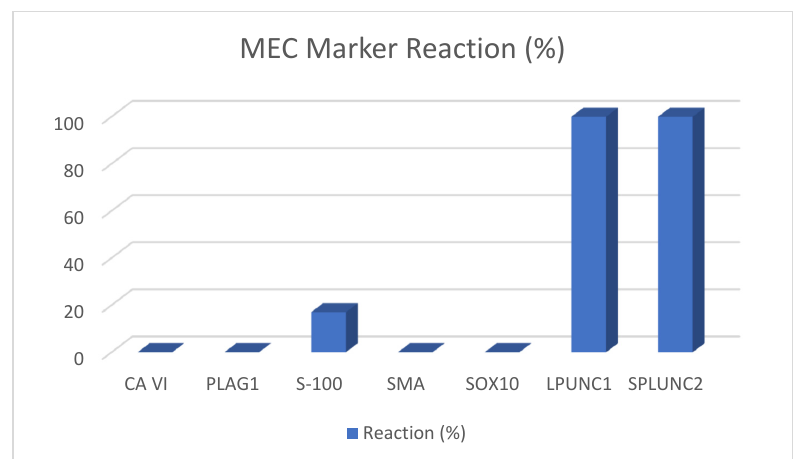
Figure 3. MEC marker reaction.